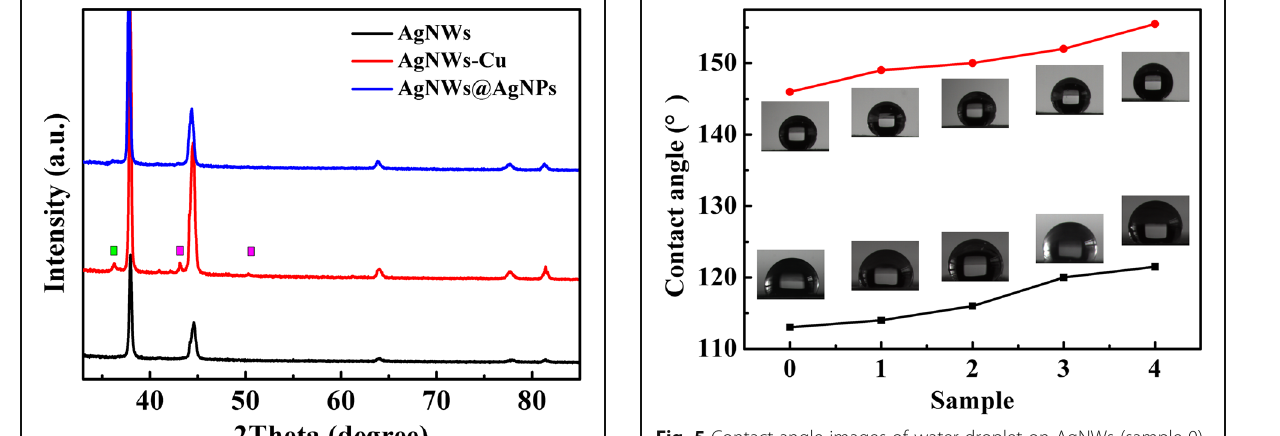
Fig. 5 Contact angle images of water droplet on AgNWs (sample 0), and AgNWs@AgNPs − 1, 2, 3, 4 composite films (sample 1, 2, 3, 4) (black) and corresponding superhydrophobic films (red). The insets the corresponding water contact angles of the